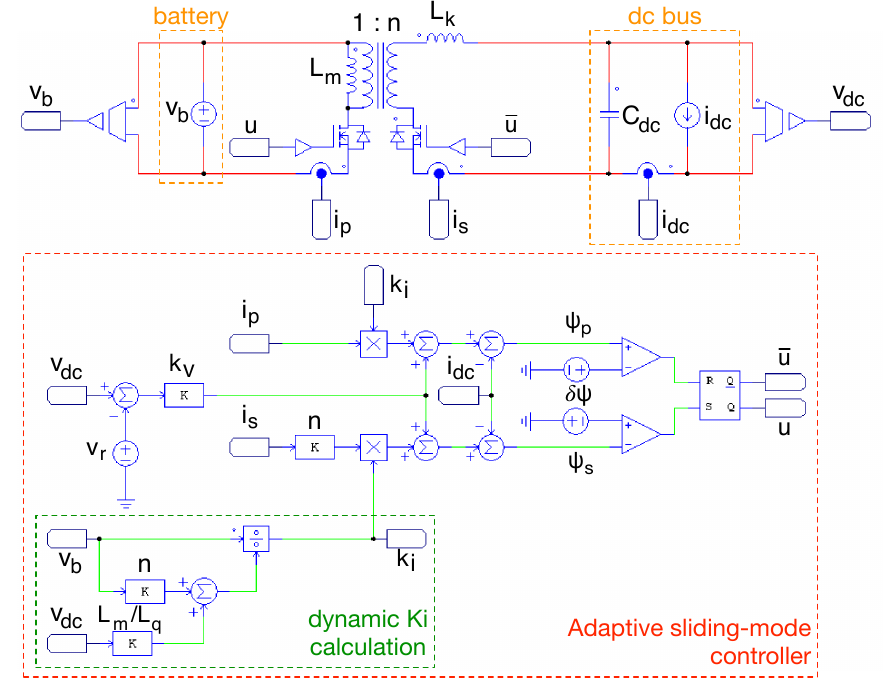
Figure 10. Circuital implementation of the battery charger/discharger in